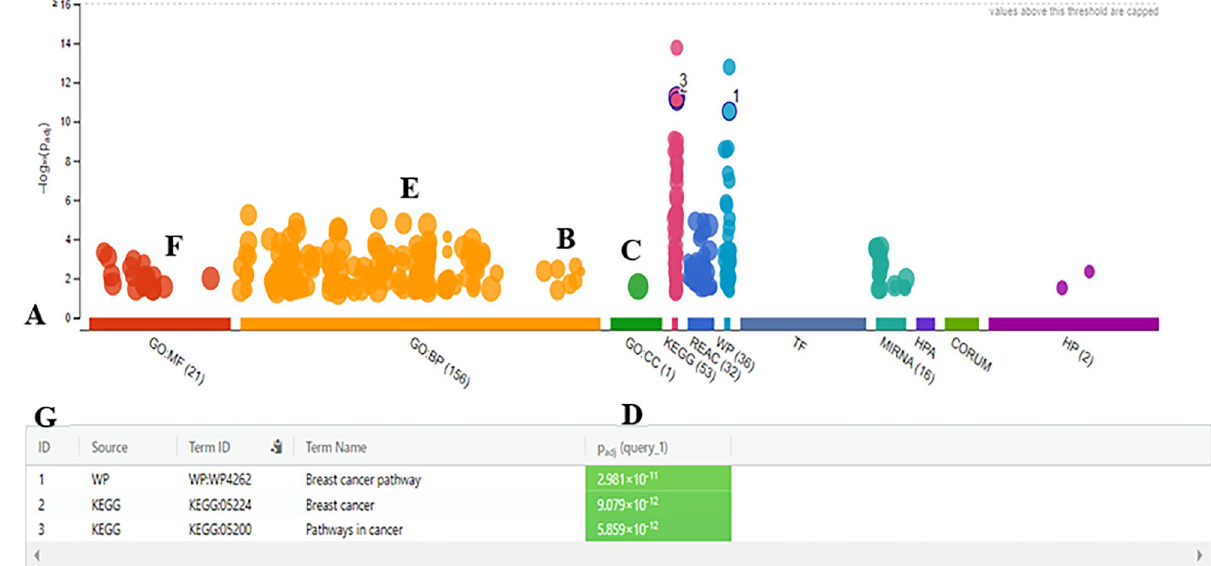
Figure 2. Functional enrichment by the g: Profiler software. ( A ) the X-axis shows the functional terms grouped and color-coded by the data source. ( B , C , F ) the position of terms in the plots fixed and terms from the same branch of Gene Ontology. ( D ) p-values in the table outputs are color-coded from yellow (insignificant) to blue (highly significant). ( E ) in a multi-query case, the same term is highlighted on other plots. ( G ) a click allows for pinning the circles to the plot with a numeric ID that creates a more detailed result in the table below the